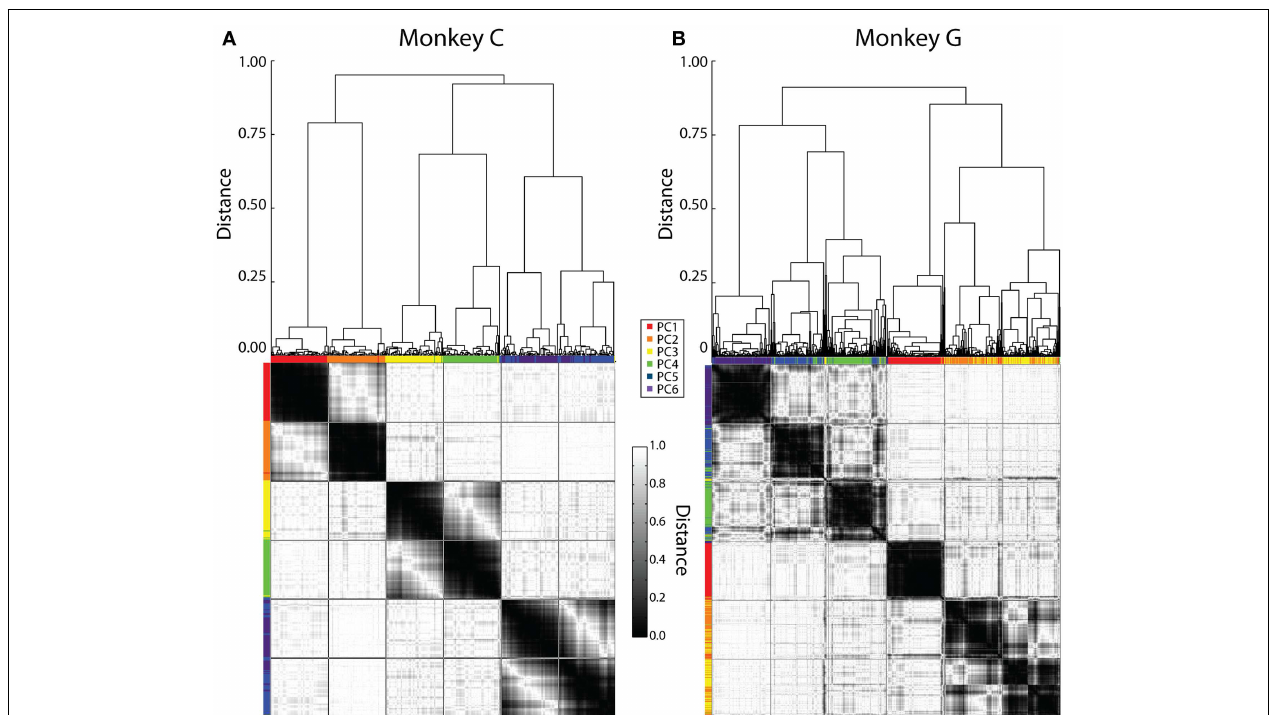
each column or row of the distance matrix.The distance matrix is symmetric about its main diagonal.The six major dark squares along this diagonal indicate that six relatively consistent kinematic synergies were present across sessions from both monkeys. Lines have been drawn on the distance matrix dividing both the rows and the columns into six groups of equal